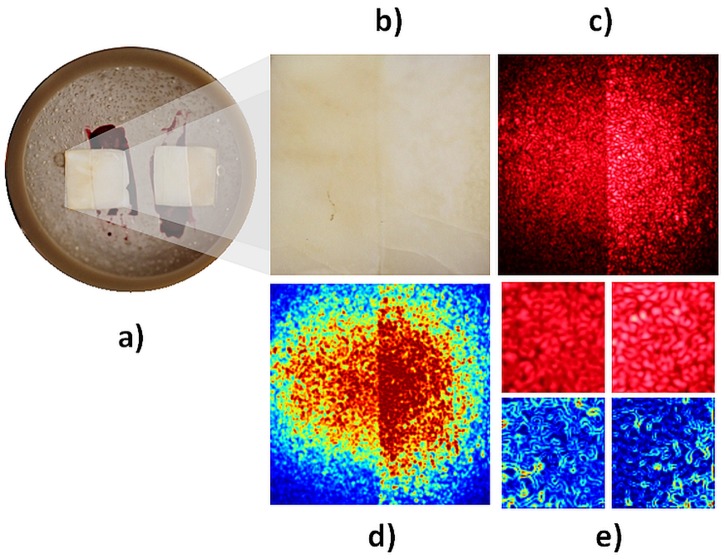
Procedure for acquisition and analysis of speckle images.(a) sample; (b) image under white light; (c) image under coherent light; (d) image with false colors; (e) LASCA method.